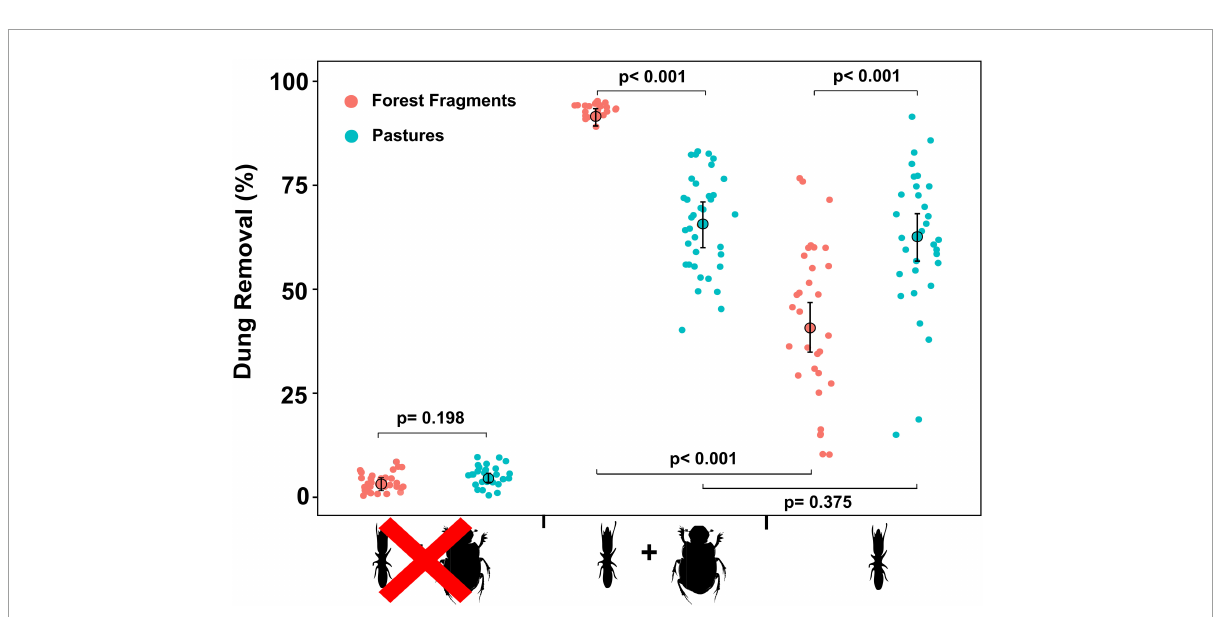
FIGURE3 Percentage of dung removal among different experimental treatments (see Table 1 for description) in the two habitat types. The plot shows de modeled mean (GLMM) represented by large circles, the modeled 95% confidence intervals of each mean (error bars), and the model-adjusted individual response values, represented by the small dots and the P -values of the least square mean analyses for pairwise